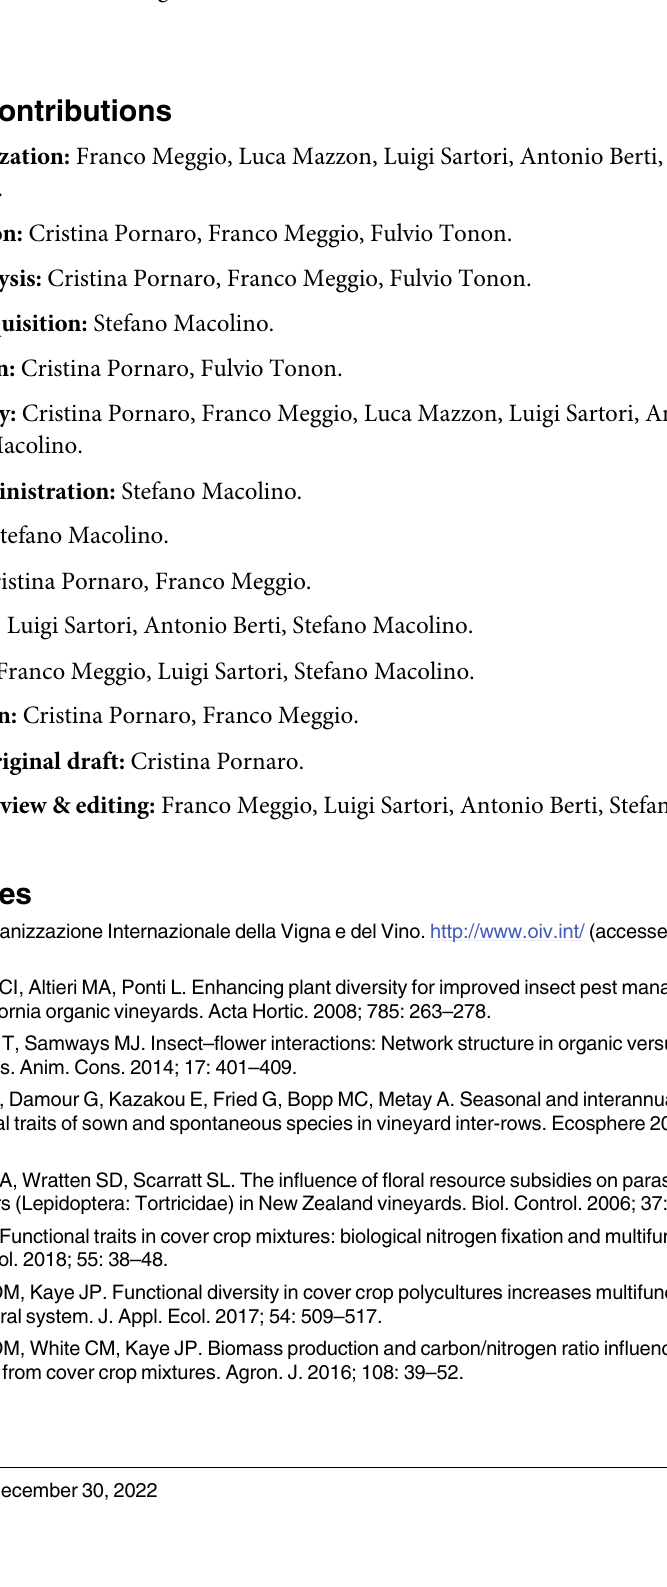
S2 Table. Particle-size distribution (averaged over 3 replicates) determined in soil erosion samples collected in 2019 and 2020. S1 = Schedonorus arundinaceus blend, S2 = Lolium per- enne blend, RV = resident vegetation, BS = bare